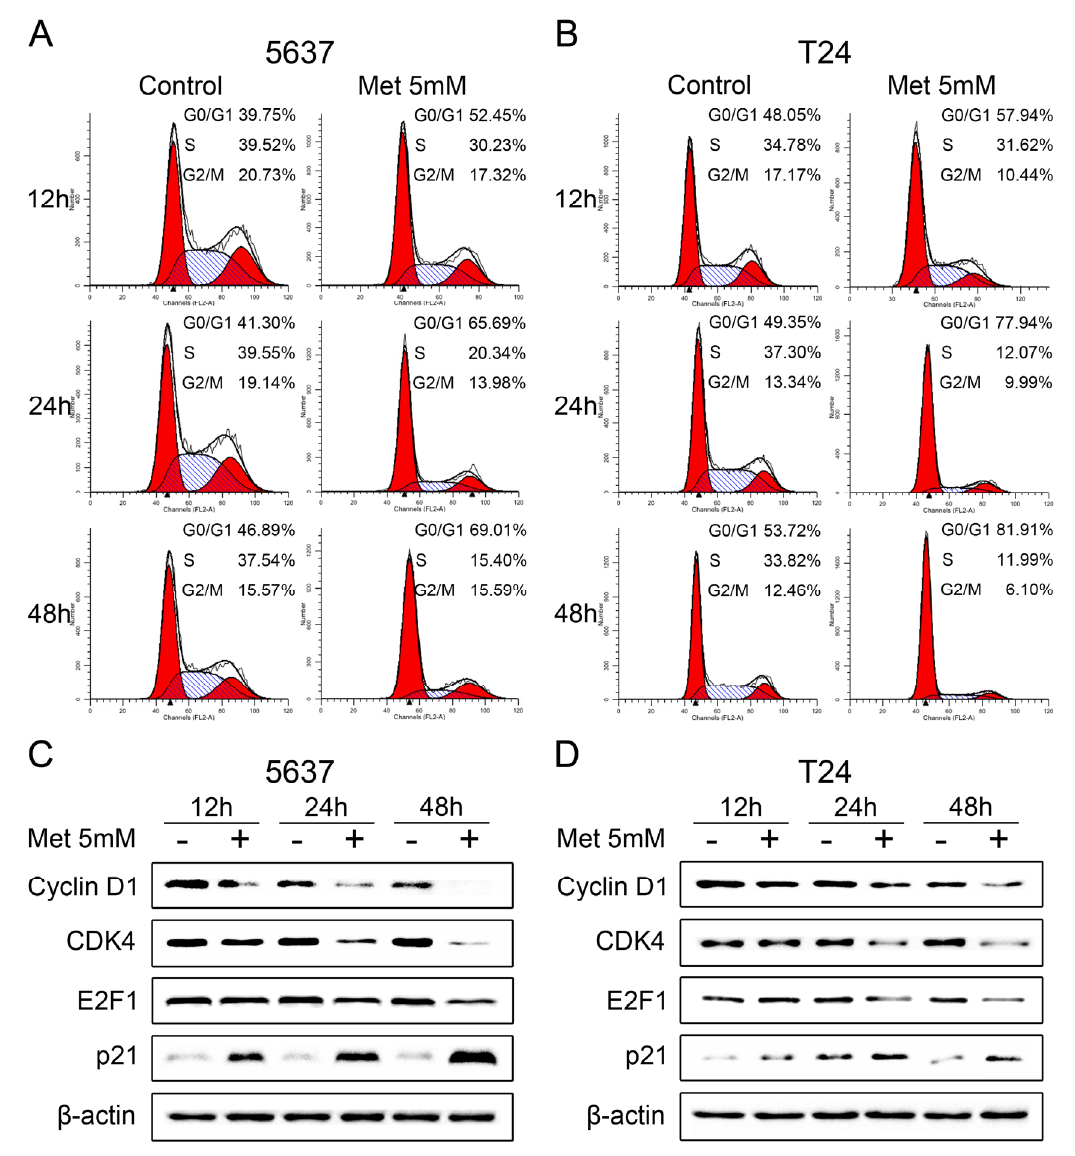
Figure 3. Metformin blocks the cell cycle in G0/G1 phases and affects the expression level of the cell cycle proteins. ( A , B ) Proliferating 5637 ( A ) and T24 cells ( B ) were treated with 5 mM metformin (Met) for the indicated time and cell cycle distributions were analyzed by flow cytometry; and ( C , D ) Western blot analysis of related cell cycle proteins in 5637 ( C ) and T24 cells ( D ) treated or not with 5 mM metformin (Met) for the indicated time. Data shown are representative of three independent experiments with similar